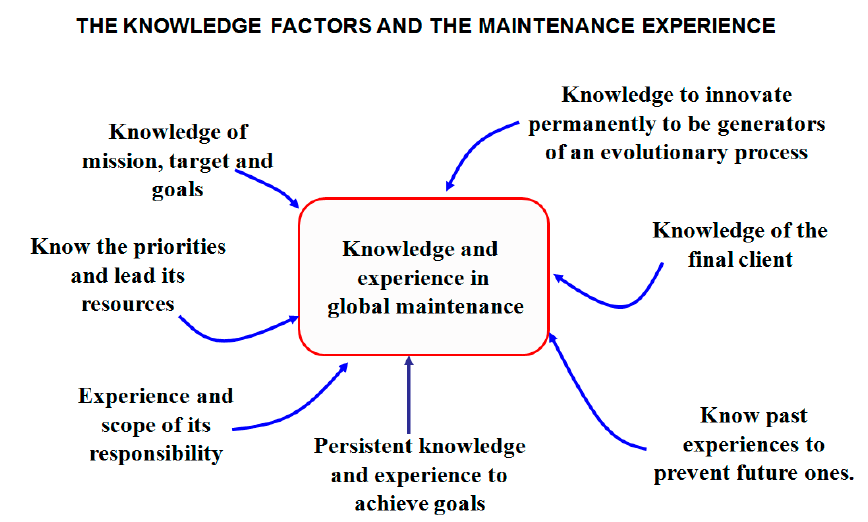
Figure 1. Knowledge factors related to maintenance.